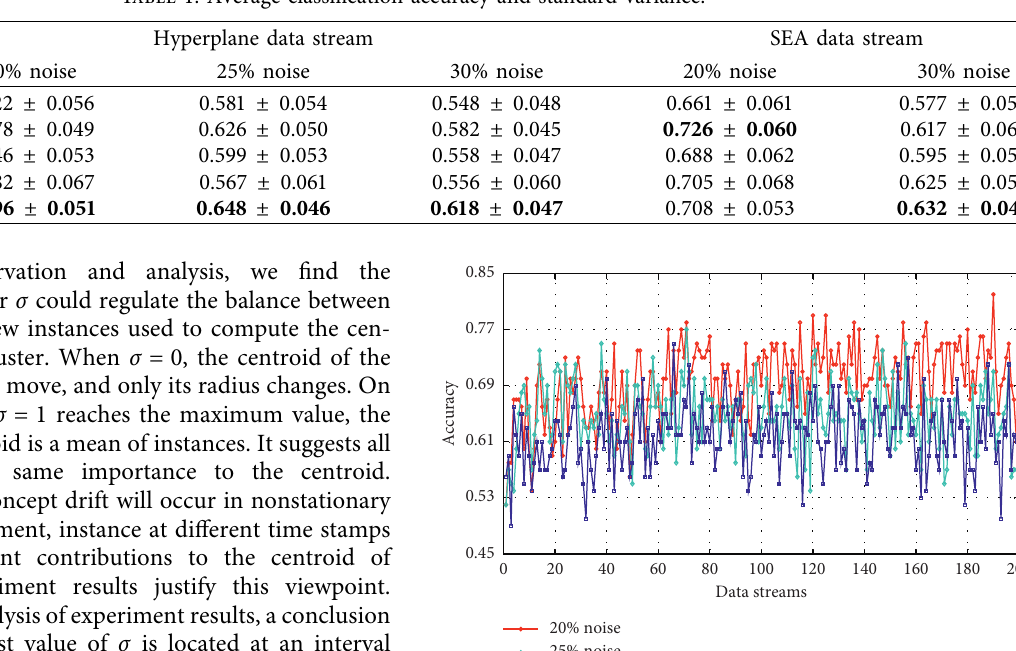
Table 1: Average classification accuracy and standard variance.